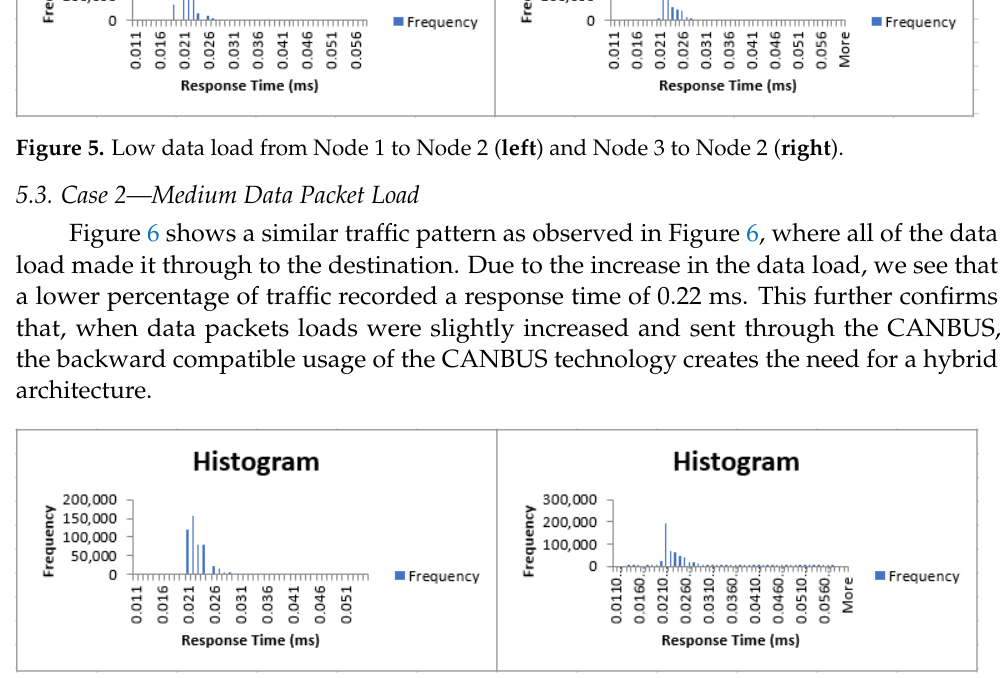
Figure 6. Medium data load from Node 1 to Node 2 ( left ) and Node 3 to Node 2 ( right